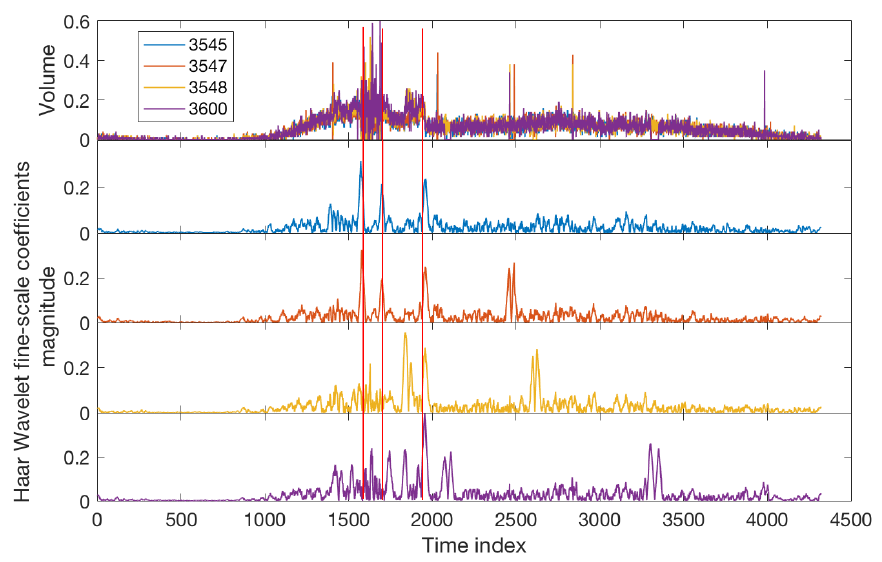
Figure 9. Incident S2: Analysis of Haar Wavelet Transform. Top panel is the volume data from four different sensors. The lower panels are the analysis results from sensors 3545, 3547, 3648, and 3600, respectively. The vertical red lines refer to the incident start time, incident end time, and queue end time, respectively (see Table